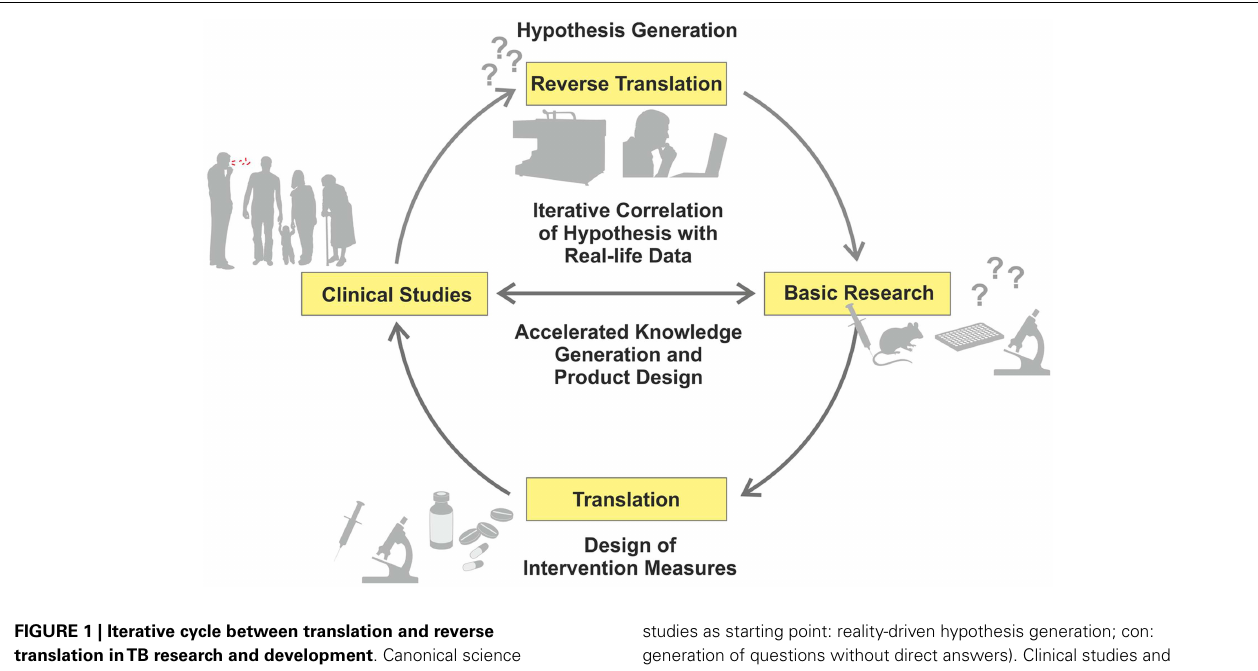
FIGURE 1 | Iterative cycle between translation and reverse translation inTB research and development . Canonical science frequently follows translational pathways from basic research to clinical studies (pro for basic research as starting point: hypothesis-driven proof of principle; con: dissociation of hypothesis from real-life). In this way, proof of principle derived from basic research can be validated under real-life conditions. Increasingly, reverse translation of clinical observations into hypothesis generation is pursued (pro for clinical